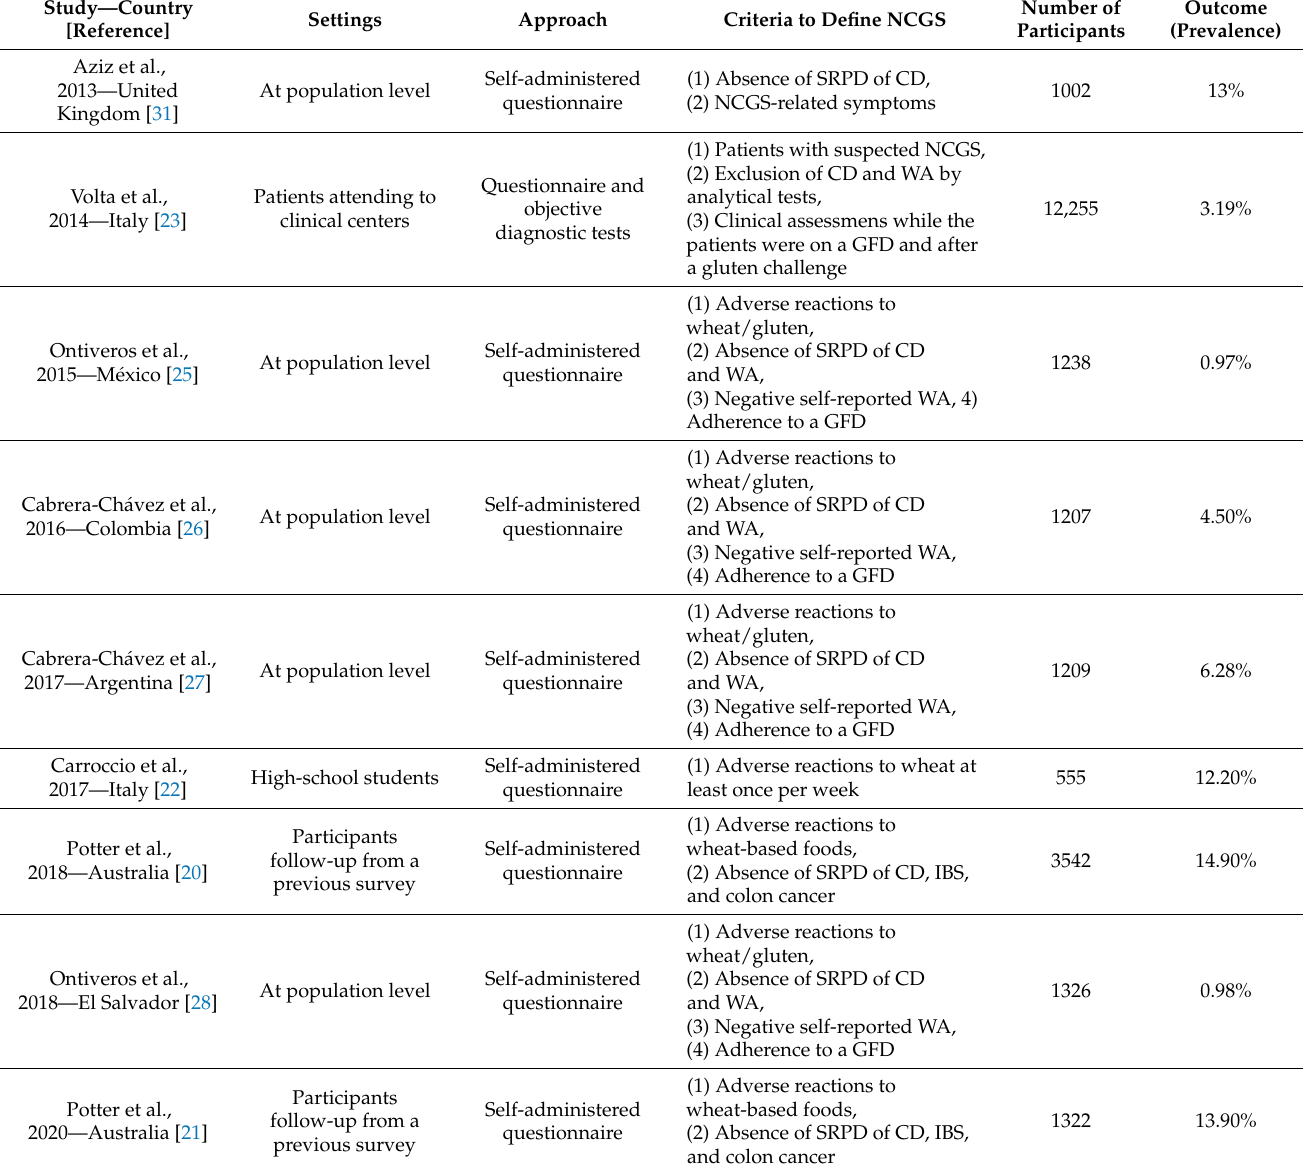
Table 1. Prevalence of NCGS across survey